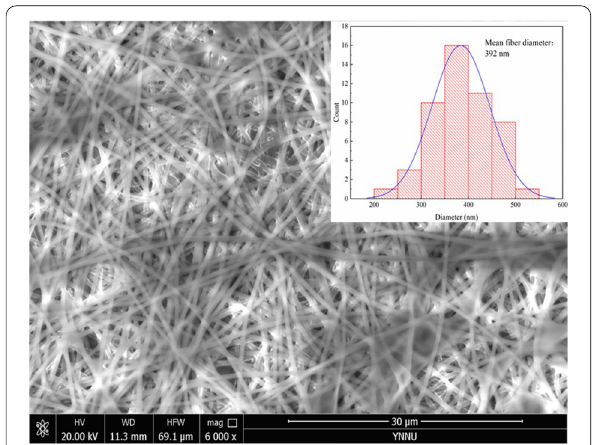
Fig. 13 SEM image and diameter distribution of raw lignin